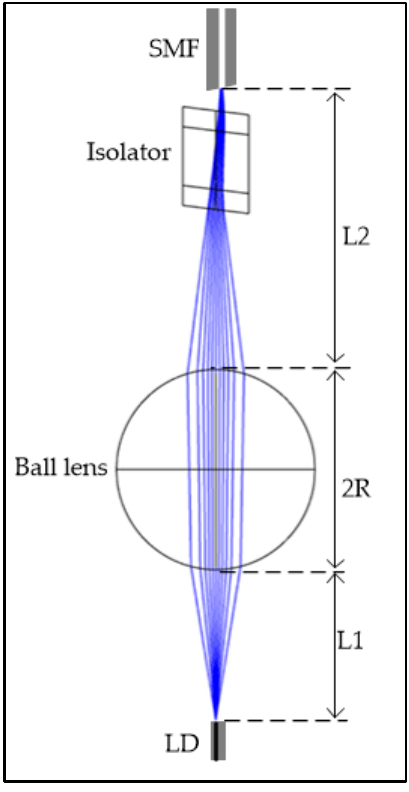
Figure 1. Optical path model of TOSA. Table 1. Variation of far-field divergence angle and focal spot.